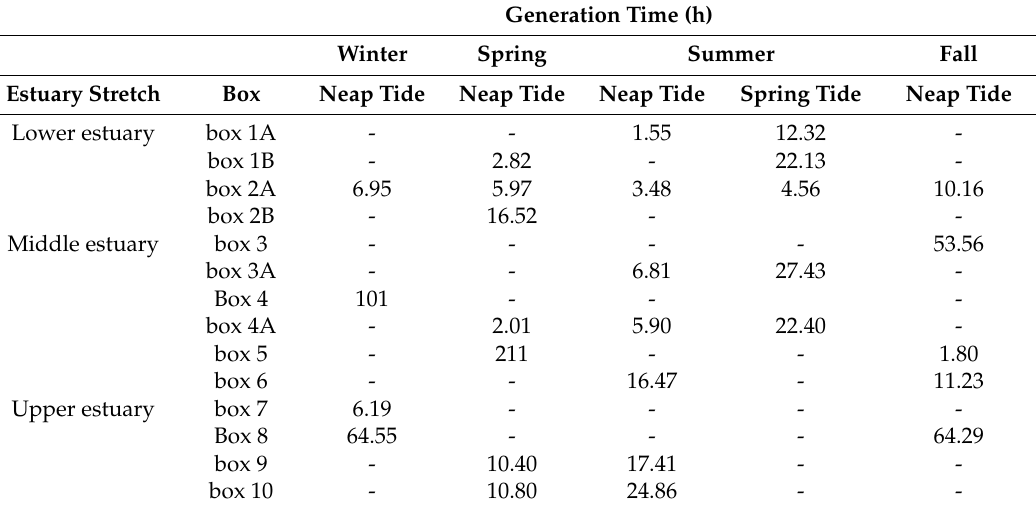
Table 2. Bacteria generation times, calculated for boxes with growth, assuming the linearity of growth over 24